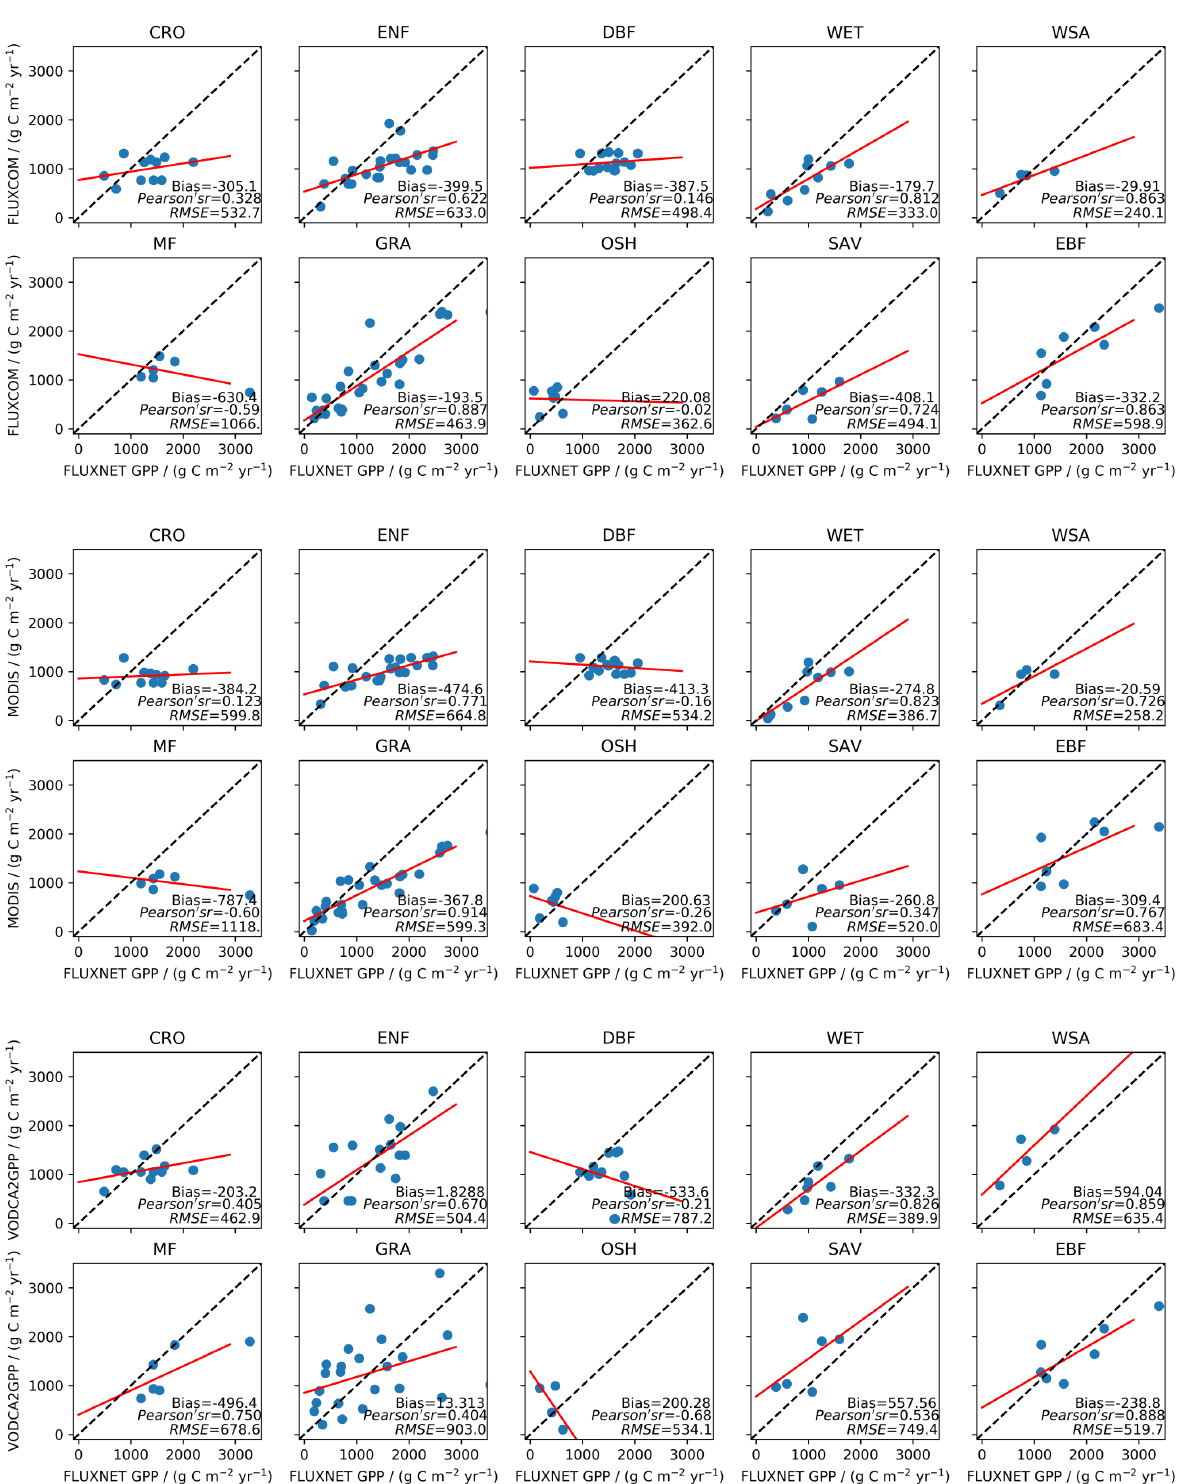
Figure A3. Scatterplots of mean annual GPP for FLUXCOM, MODIS, and VODCA2GPP for the period 2002–2016 per vegetation type. Vegetation types indicate the predominant IGBP vegetation type at the respective FLUXNET station. Abbreviations are as follows: CRO, croplands; ENF, evergreen needleleaf forests; DBF, deciduous broadleaf forests; WET, permanent wetlands; WSA, woody savannas; MF, mixed forests; GRA, grasslands; OSH, open shrublands; SAV, savannas; EBF, evergreen broadleaf forests.